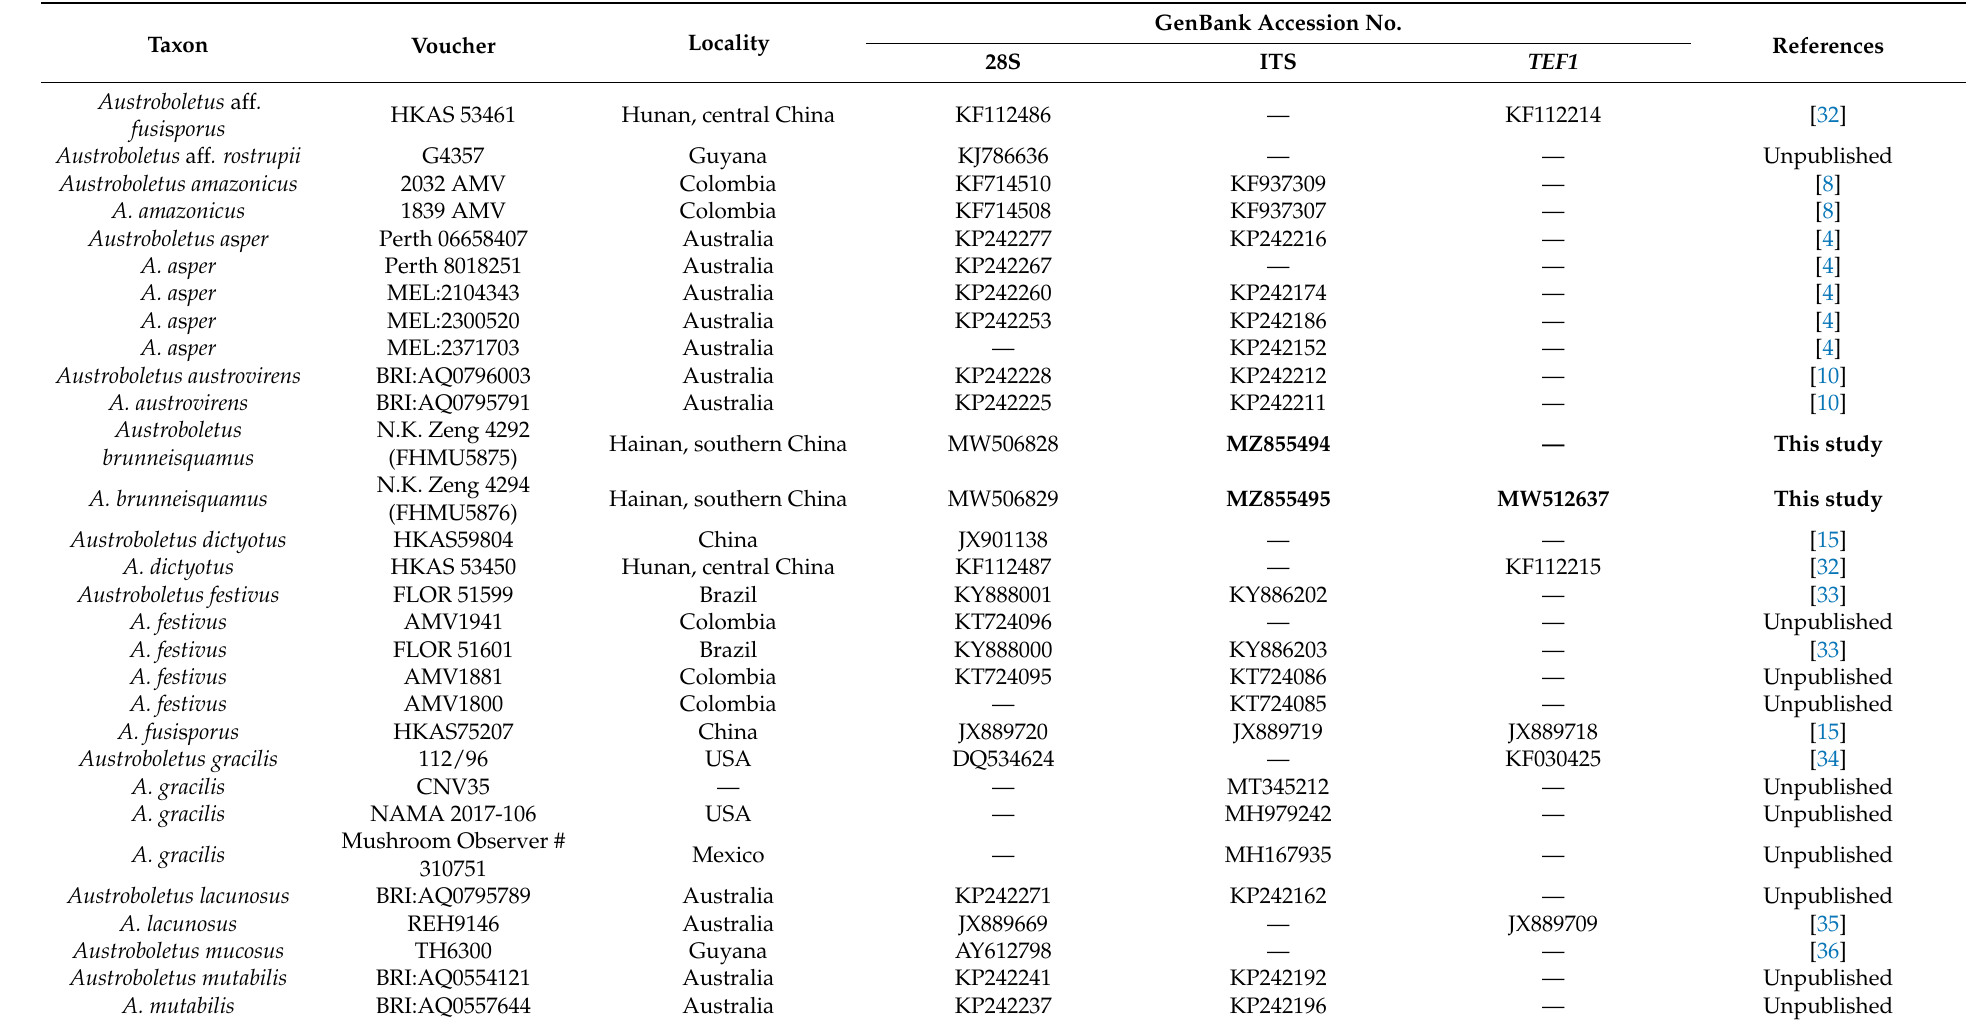
Table 1. List of collections used in this